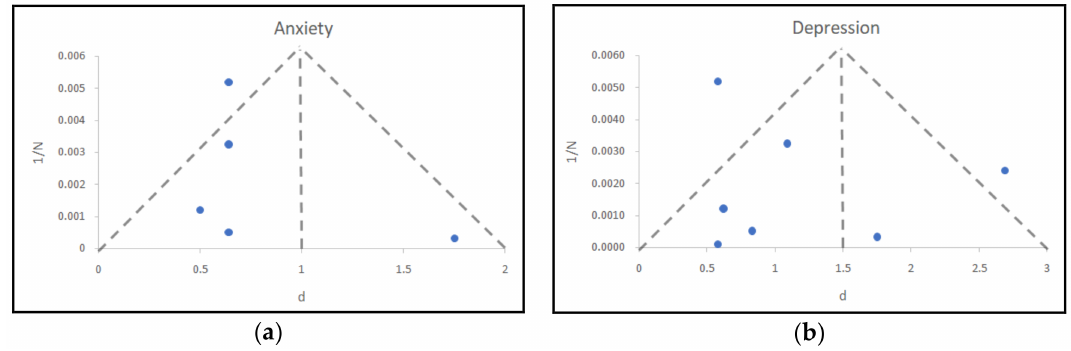
Figure 2. Funnel plots with pseudo-95% confidence limits: ( a ) anxiety, ( b )